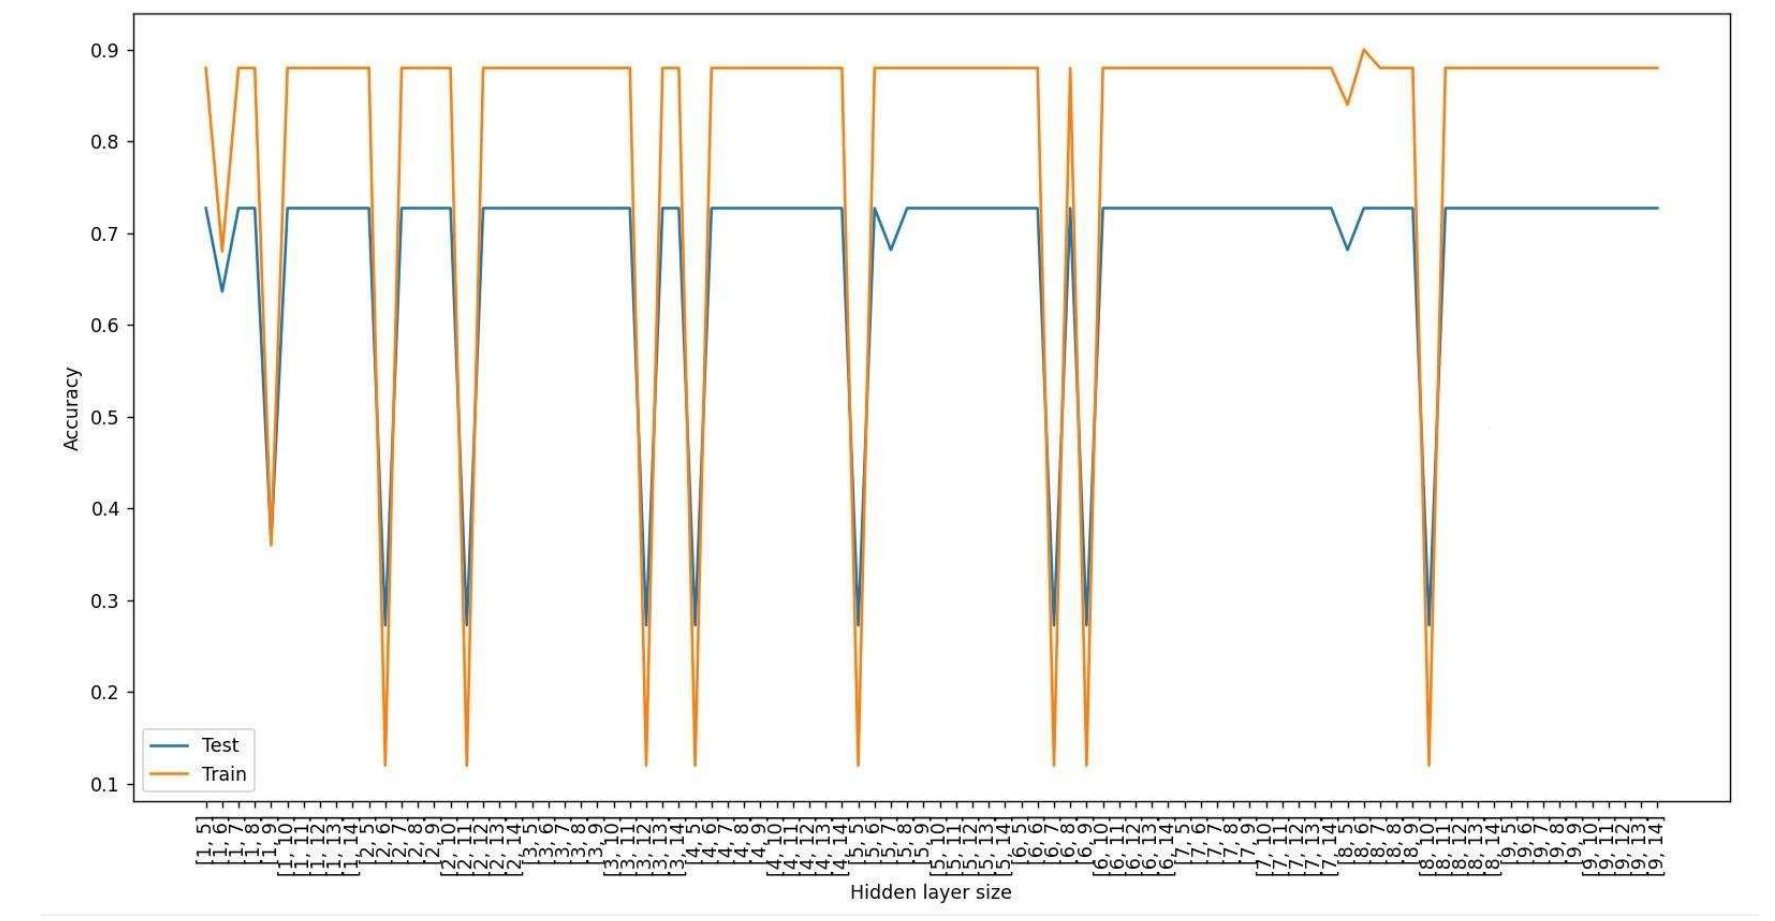
Figure 5. Accuracy of the MLP model (I = (1, 10), j = (5, 15)). Note: MSE= 0.083; Scores (Cross validation with cv = 5) = [0.8, 0.8, 0.857, 0.857, 0.857].